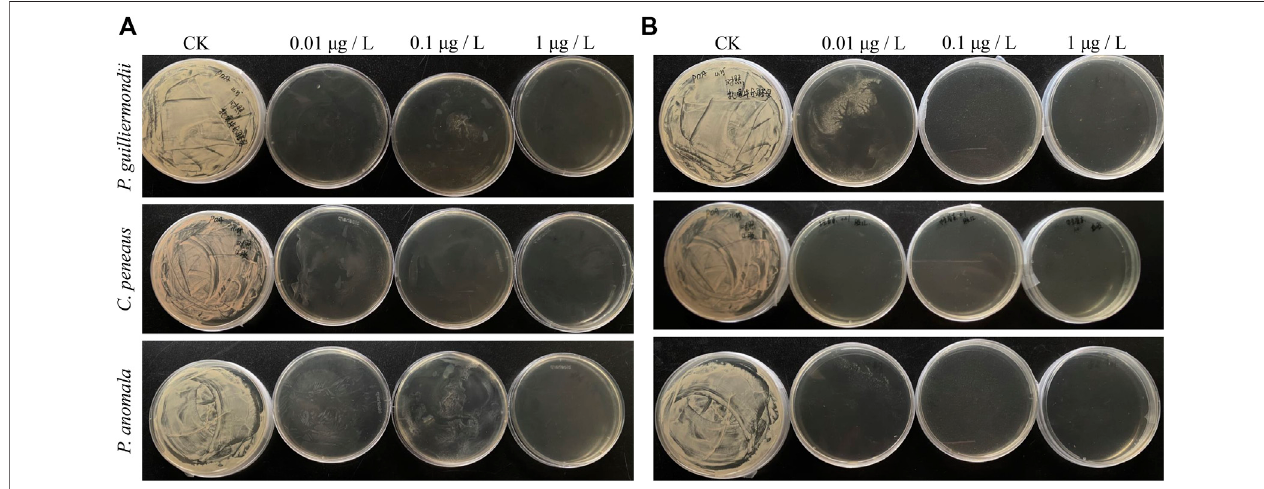
FIGURE 1 | The growth of YLSs isolated from Nilaparvata lugens at different concentrations of antimicrobials. (A) Tebuconazole; (B)